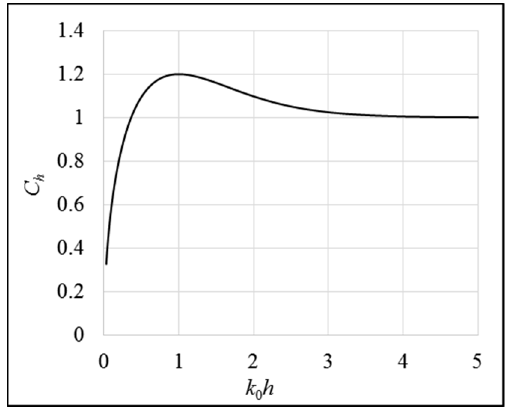
Figure 1. Modification coefficient C h .